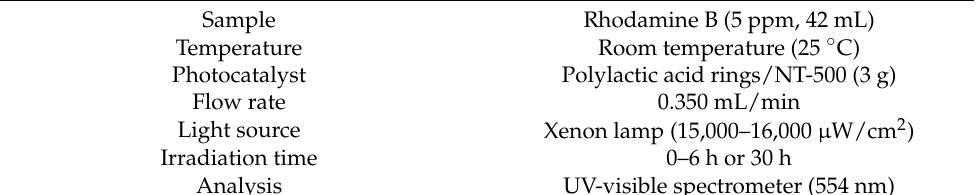
Figure 2. Photocatalytic RhB degradation of the NT-500 coating polylactic acid (PLA) prepared in different solutions for coating under flow conditions (flow rate 0.700 mL/min).